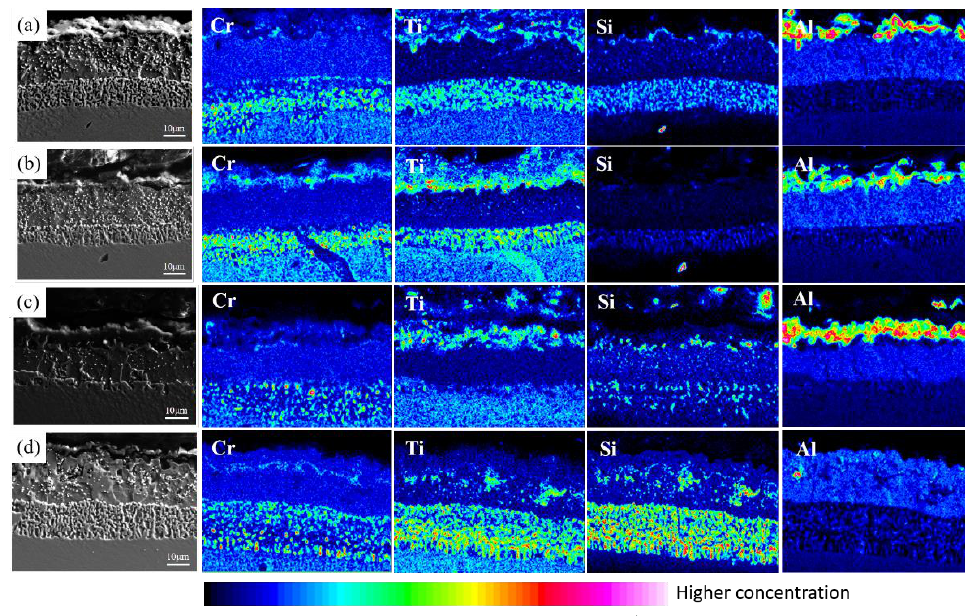
Figure 15. Element distribution of Al-Si coating section with different pre-oxidation times: ( a ) 3 h; ( b ) 5 h; ( c ) 7 h; ( d ) 9 h.